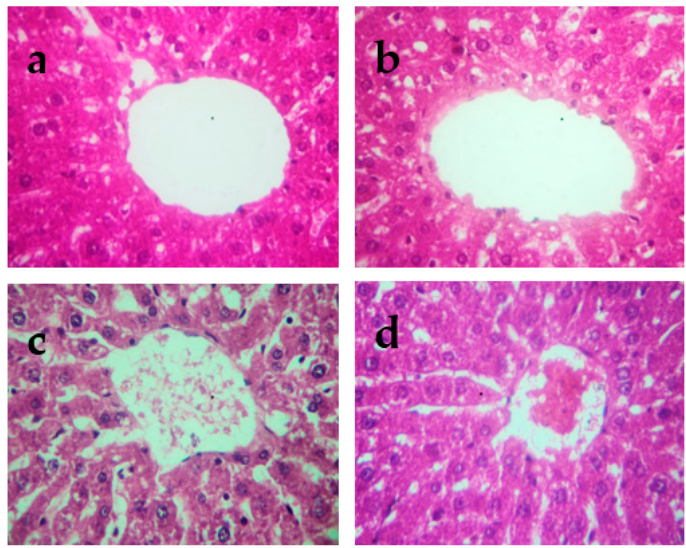
Figure 4. Representative photographs from the liver showing the protective effect of juice extract against Cd-induced hepatic damage in rats (H&E 40×). ( a ) Normal rat liver showing normal hepatic parenchyma and intact central vein. ( b ) Juice extract (250 mg/kg)-treated rat liver showing normal appearance of hepatocytes around the central vein. ( c ) CdCl 2 (1 mg/kg)-treated rat liver showing extensive degeneration of hepatocytes with focal necrosis, vacuolated cytoplasm, inflammatory cell infiltration, and damaged central vein. ( d ) CdCl 2 + juice extract (250 mg/kg)-treated rat liver showing near-normal hepatic architecture and normal histological features.